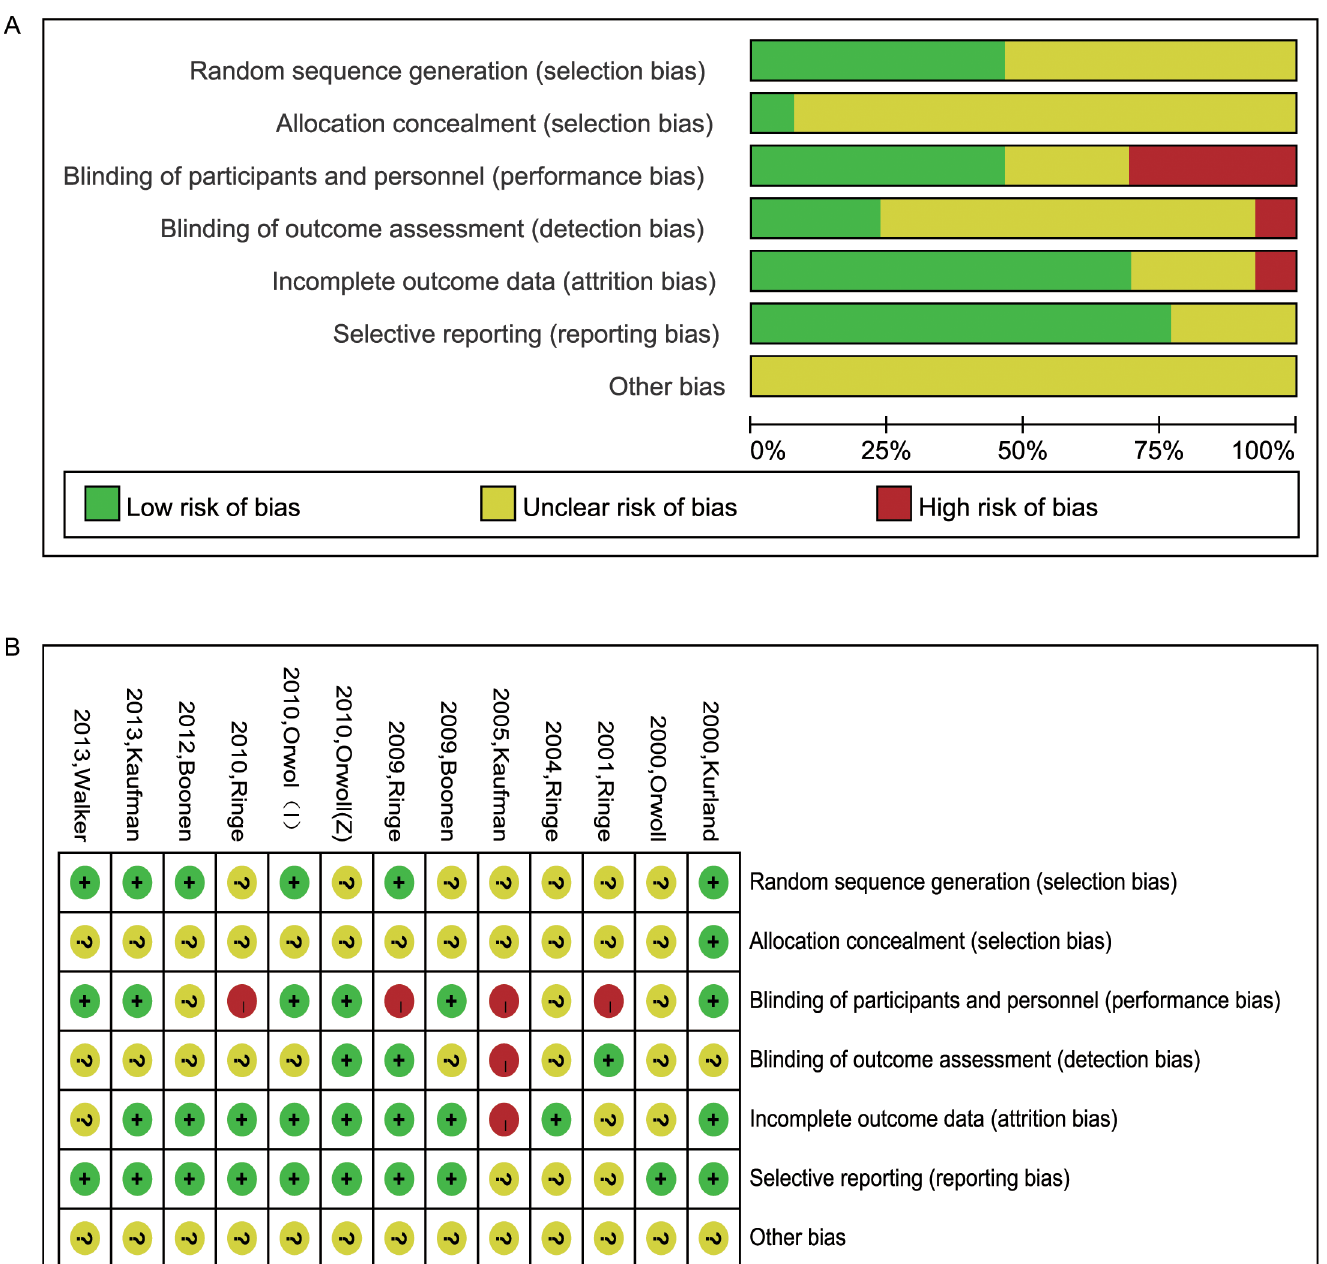
Fig 2. Risk of bias graph and summary. Panel A: Risk of bias graph: review authors ’ judgments about each risk of bias item presented as percentages across all included studies. Panel B: Risk of bias summary: review authors ’ judgments about each risk of bias item for each included study.